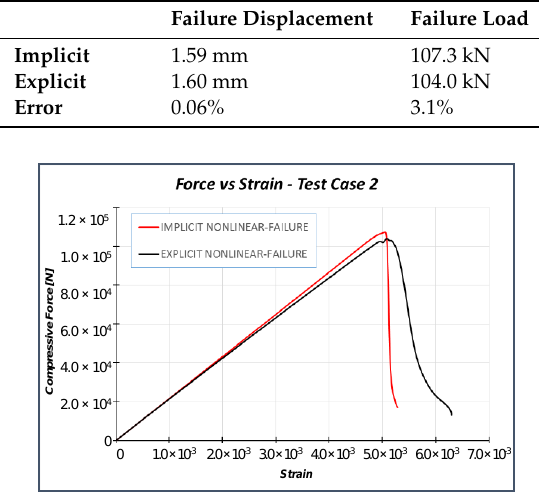
Figure 9. Implicit–explicit formulation comparisons: Load vs. strain.